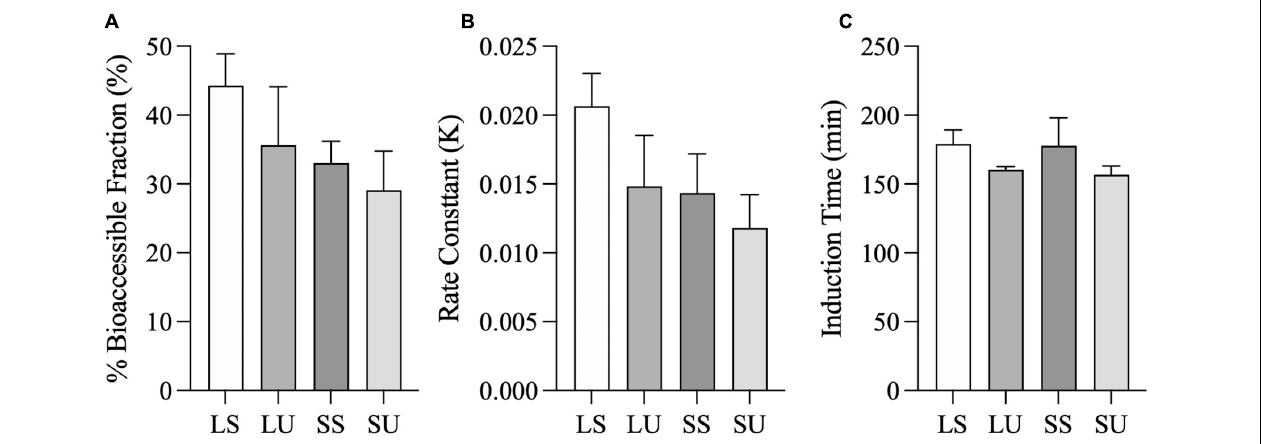
FIGURE 7 | Total fatty acid bioaccessible fraction (i.e., C asymp ) (A) , rate constant (i.e., K) (B) , and induction time (i.e., t c ) (C) , calculated from the shifted logistic model for the combined jejunal and ileal filtrates. Error bars represent SEM for three replicates. No significant differences between samples were observed ( p > 0.05).